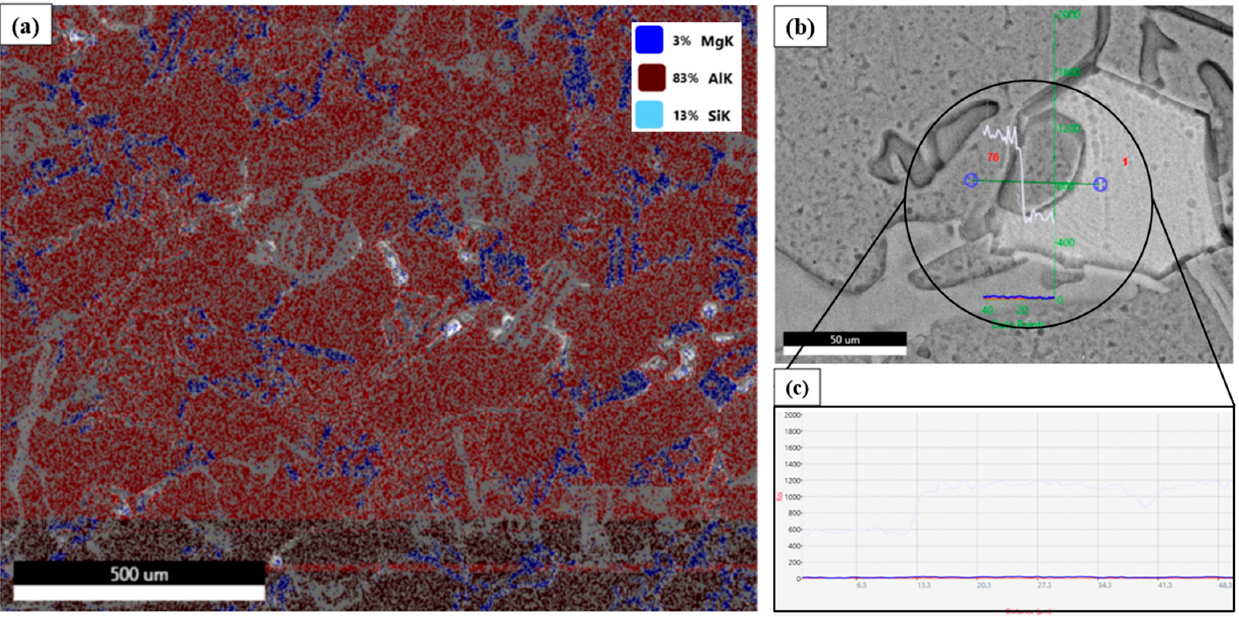
Figure 5. EDS analysis of fabricated MMC in (a) map of Mg, Al, and Si content and (b) line-scan method representing Si content ..